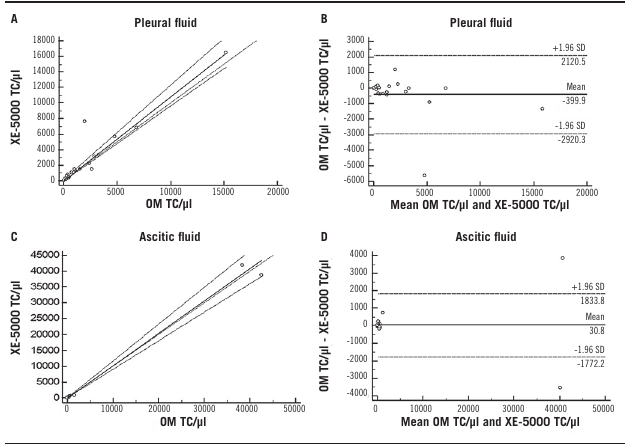
figurE 1 − Comparison of the body fluid total cell counts between the XE-5000 and the manual optical microscopy A) Passing-Bablok regression analyses for TC-BF count in pleural fluid. Cusum test for linearity indicates no significant deviation from linearity ( p > 0.1); B) Bland-Altman plot for TC-BF count between manual optical microscopy (OM) and the XE-5000 in pleural fluid; C) Passing-Bablok regression analyses for TC-BF count in peritoneal fluid. Cusum test for linearity indicates no significant deviation from linearity ( p > 0.1); D) Bland- Altman plot for TC-BF count between MOM and the XE-5000 in peritoneal fluid. TC-BF: body fluid total cell count; OM: manual optical microscopy; SD: standard deviation; Cusum: cumulative